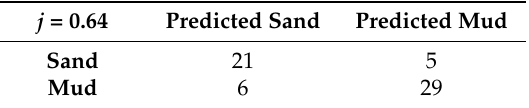
Table 9. Confusion matrix for classification at Appledore using an artificial neural network fed with HSV and NIR data channels. Calculated j values are given in the upper left cell.